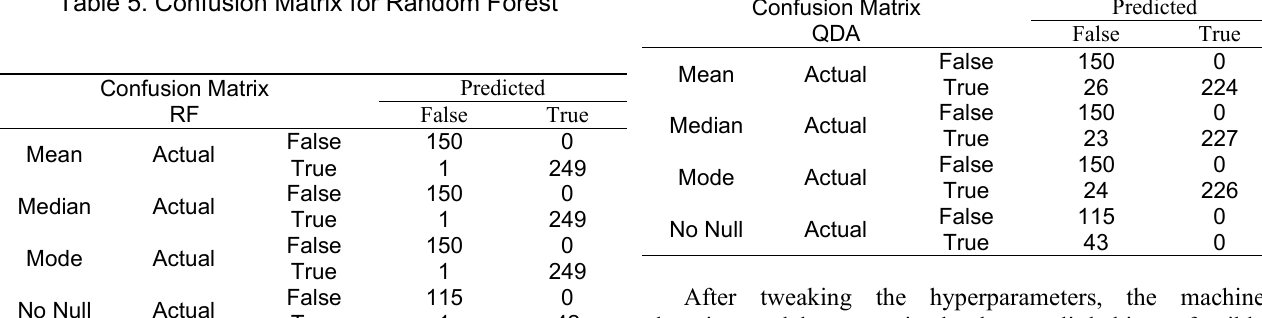
Table 5. Confusion Matrix for Random Forest